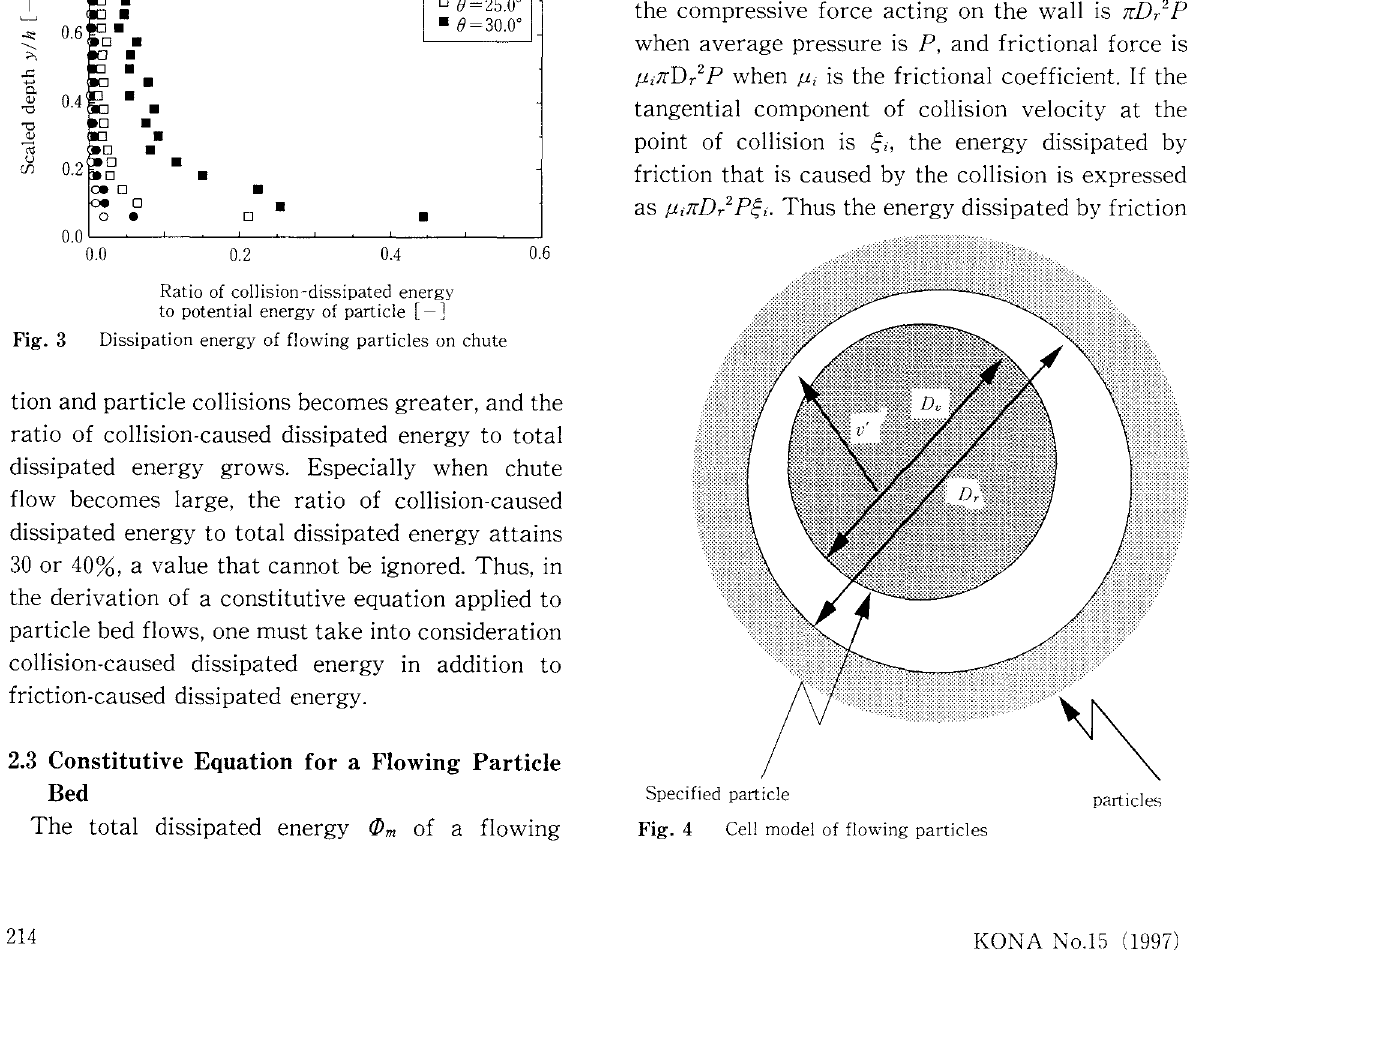
Cell model of flowing